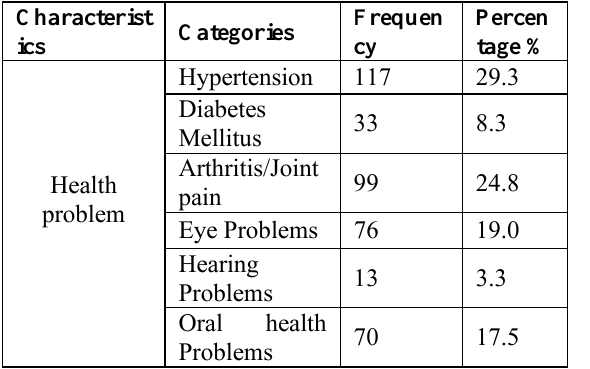
Table 2. Types of first approach of